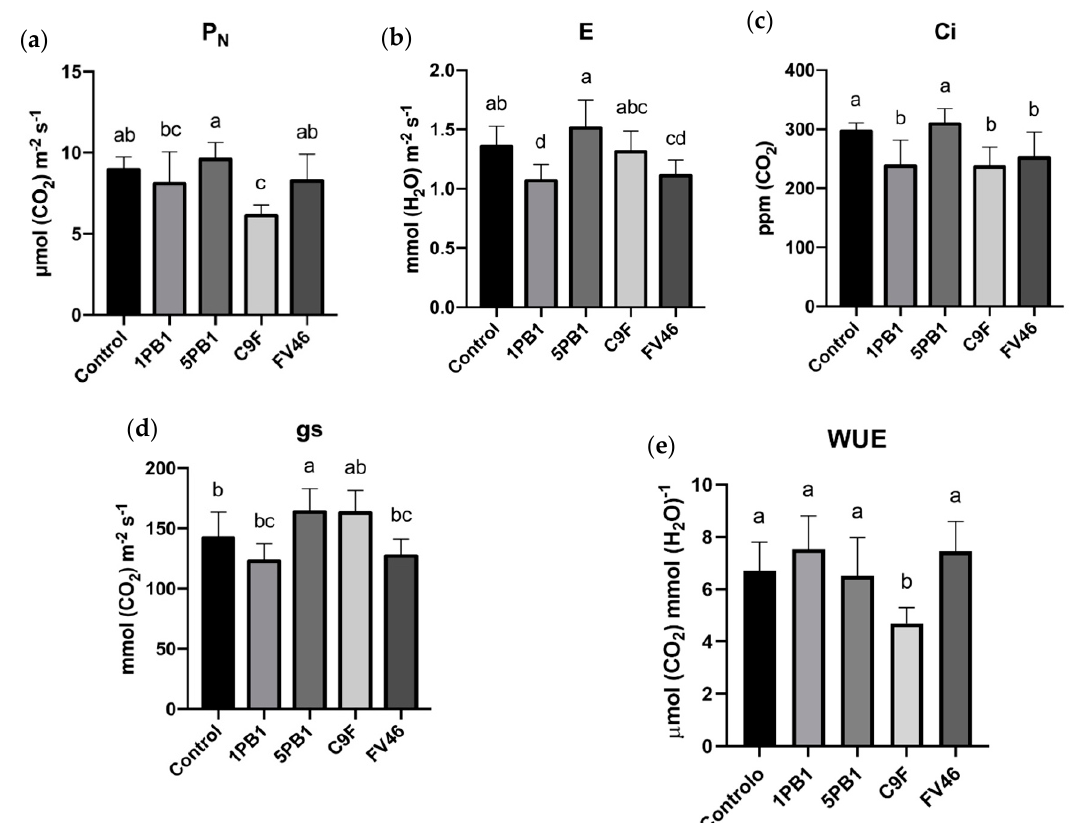
Figure 4. Effects of inoculation with 1PB1, 5PB1, C9F and FV46 on gas exchange parameters of 130-day-old tomato plants (n = 8); ( a ) PN—net photosynthetic rate; ( b ) Ci—internal CO 2 concentration; ( c ) gs—stomatal conductance; ( d ) E—transpiration rate; ( e ) WUE—water use efficiency. Means with the same letter are not significantly different according to the Dunnett test ( p <